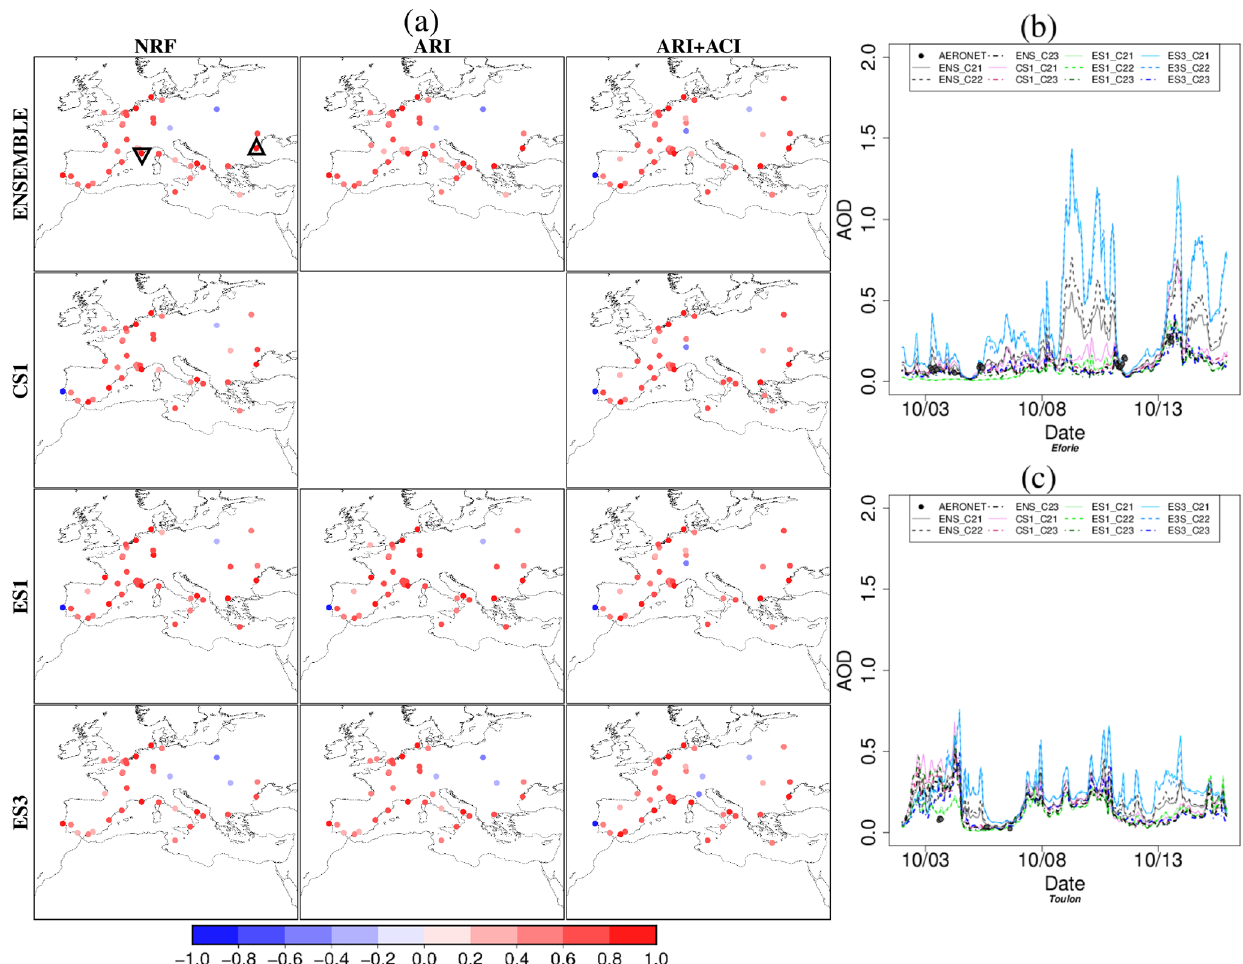
Figure 7. Model–AERONET comparison of AOD at 670nm for the Saharan desert dust outbreak case: (a) temporal correlation values at each AERONET station, (b) temporal series at the Eforie (located at triangle pointing upwards) and (c) Toulon (located at triangle pointing downwards)